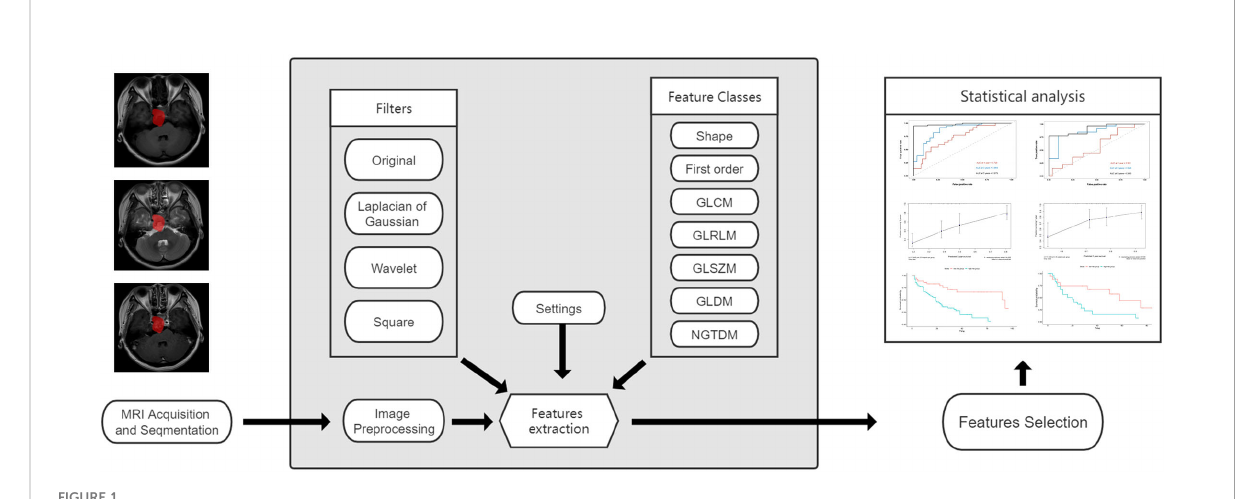
FIGURE 1 The fl ow chart of the